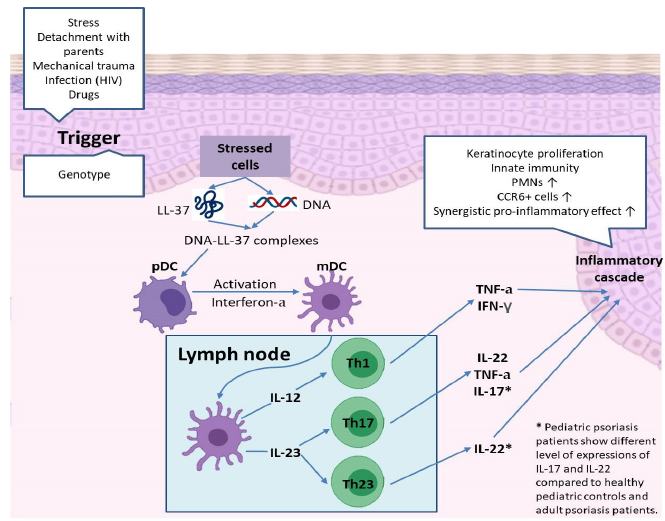
Figure 1. Pathogenesis of psoriasis focusing on the immunologic